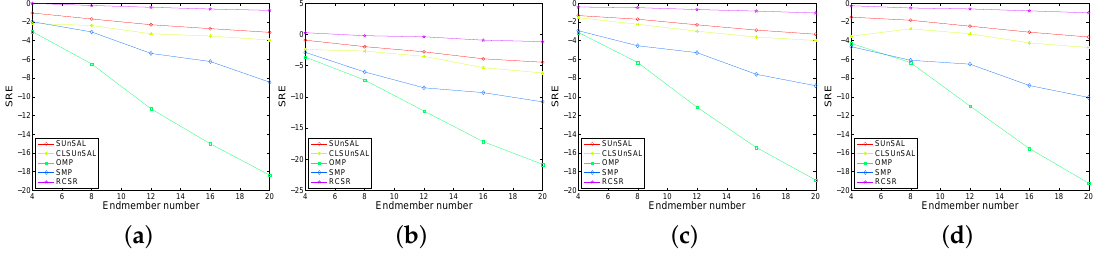
Figure 1. Performance of SRE as a function of the number of endmember under Gaussian white noise when the SNR is 10 with the ( a ) LMM; ( b ) FM; ( c ) GBM and ( d ) MGBM.